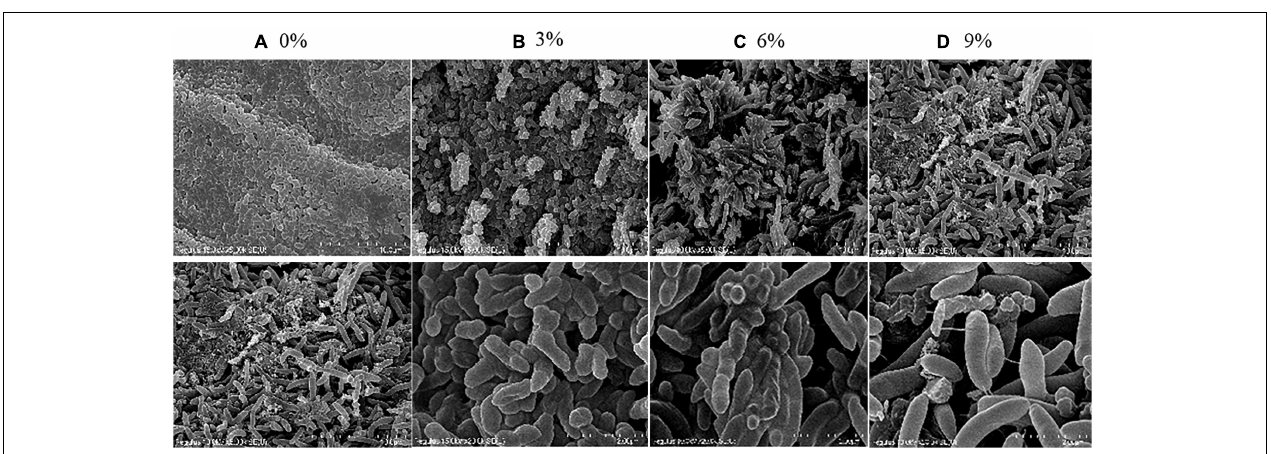
FIGURE 2 | Morphological changes in R. aquatilis JZ-GX1 at different salinities. (A–D) show scanning electron microscopy images of cells in the presence of 0, 3, 6, and 9% NaCl, respectively, with the scale bars indicating 10 or 2 µ m.